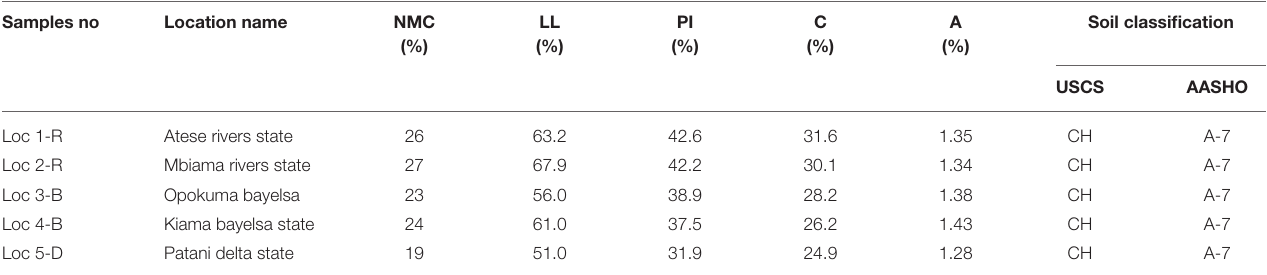
TABLE 4 | Physical properties of studied active soils. Samples